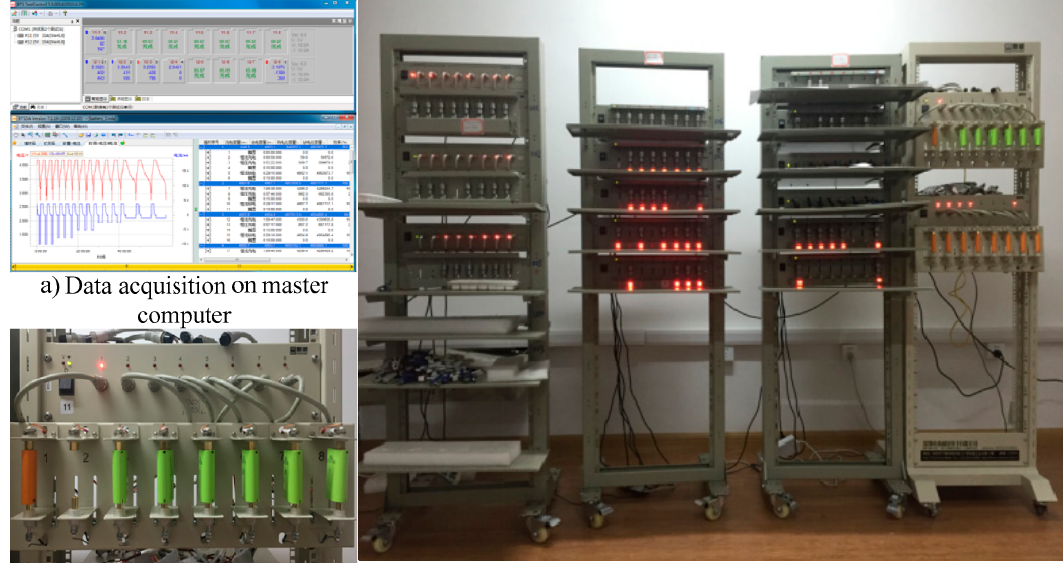
Figure 9. NEWARE battery test system.